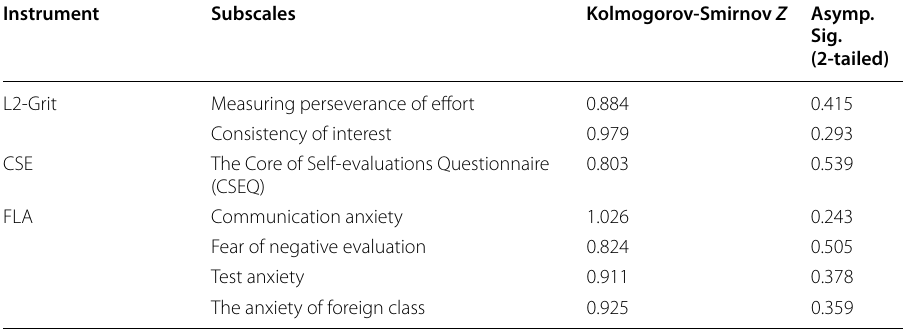
Table 2 The results of Kolmogorov-Smirnov test